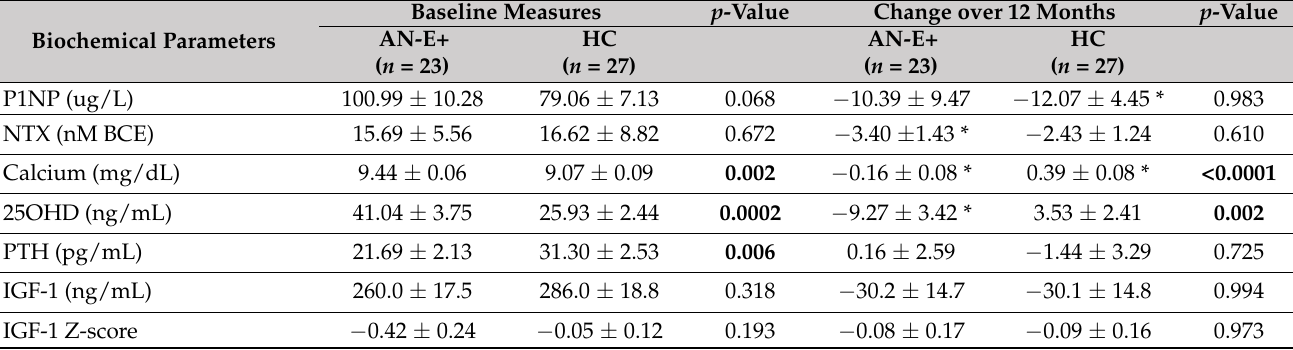
Table 2 reports baseline bone parameters and changes over 12-months. Table 2. Baseline levels and changes in biochemical parameters over 12